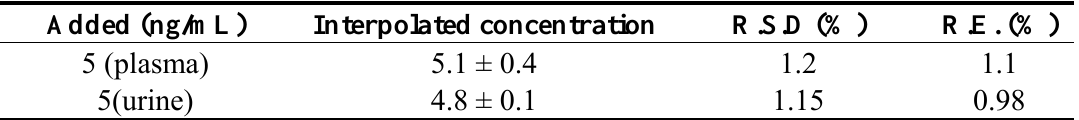
Data obtained from five replicates at each concentration. Interpolated concentration data expressed as mean ±S.D.